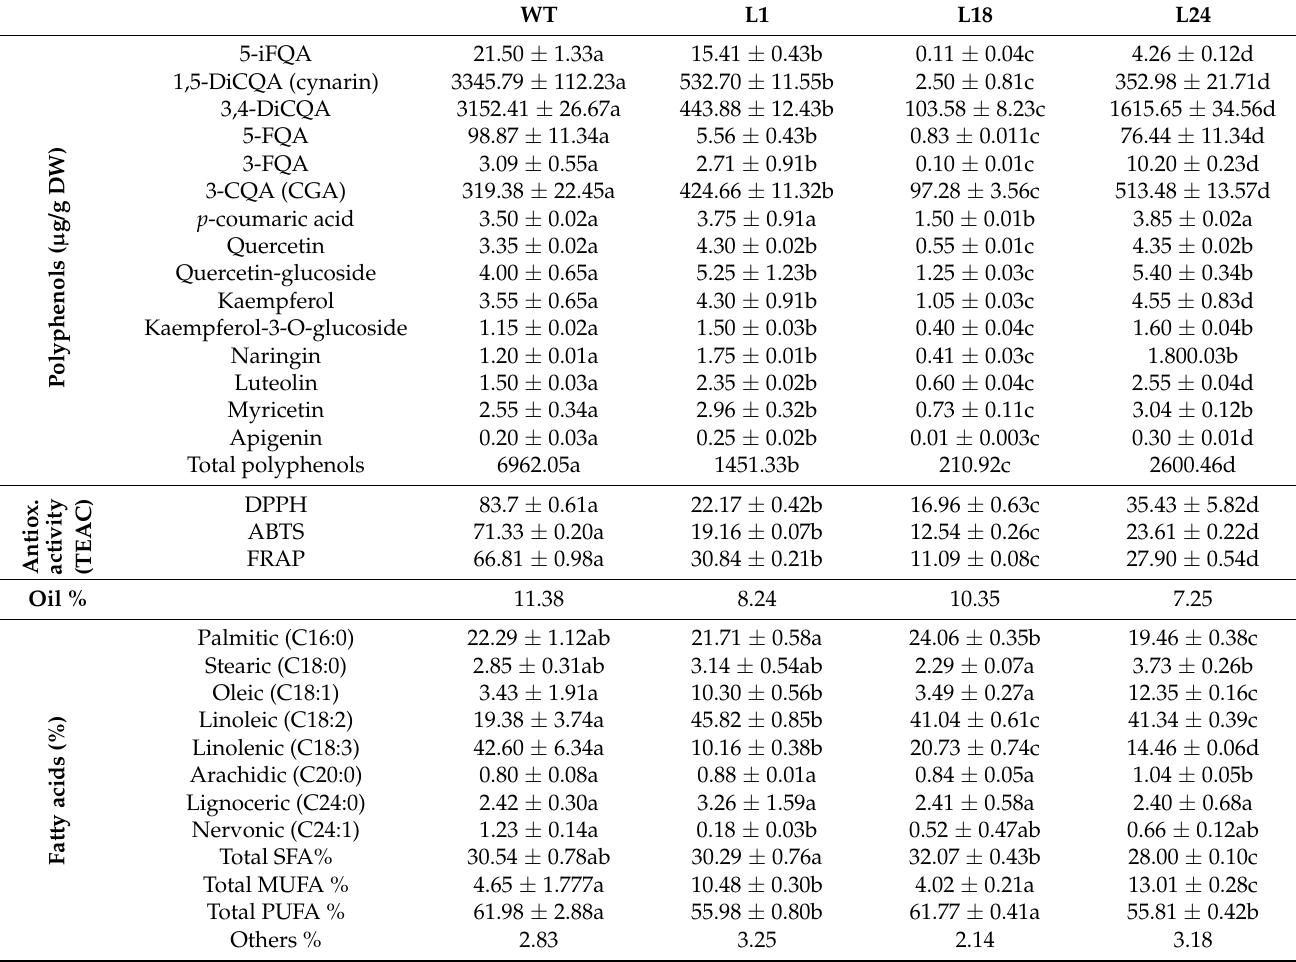
Table 1. Biochemical characterization of WT and AtMYB4oe lines. Polyphenols content detected by HRMS-Orbitrap: values are expressed in ppm = µ g/g dry weight, DW. 5-iFQA = 5-isoferuloyl quinic acid; 1,5-DiCQA = 1,5-dicaffeoyl quinic acid (cynarin); 3,4-DiCQA = 3,4-dicaffeoyl quinic acid; 5-FQA = 5-feruloyl quinic acid; 3-FQA = 3-feruloyl quinic acid; 3-CQA = 3-caffeoyl quinic acid (chlorogenic acid, CGA). Antioxidant activities were measured via 2,2-diphenyl-1- picrylhydrazyl (DPPH), 2,2’-azino-bis 3-ethylbenzothiazoline-6-sulfonic acid (ABTS) and Ferric Reducing Antioxidant Power (FRAP) assays. Values are expressed as TEAC: Trolox ® -equivalent antioxidant capacity mmol Trolox/kg DW. Each value shown represents the mean values ± S.D. of three biological and two technical replicates. Fatty acids content was detected by GC-FID. Values are expressed as % of total; SFA = saturated fatty acids; MUFA = monounsaturated fatty acids; PUFA = polyunsaturated fatty acids. Different letters denote a significant difference among lines through analysis of variance (ANOVA). Statistical significance was defined as p < 0.05, using the Tukey’s post hoc test for mean separation. WT L1 L18